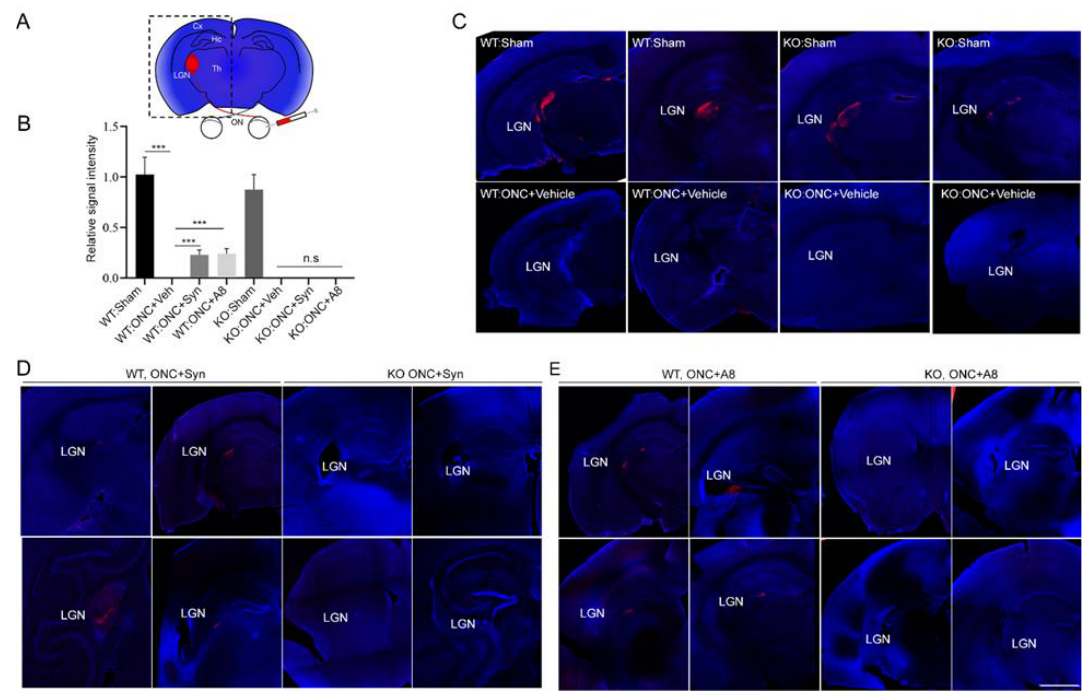
Figure 3. Intravitreal injection of GPR110 ligands partly prevented the ONC-induced loss of optic nerve axons at the target. ( A ) Schematic representation of a brain section depicting the visual system labeled by the CTB injection. The axons of retinal ganglion cells exit the eye via the optic nerve (ON) and project to the contralateral lateral geniculate nucleus (LGN) through the optic tract (OT). ( B ) The CTB fluorescent intensities were quantified by setting the whole captured image as the